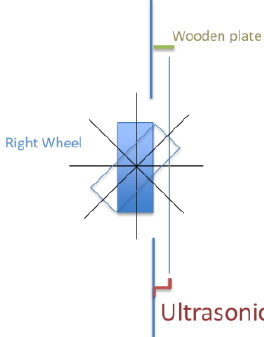
Figure 2. Plan of the Ultrasonic sensor installation